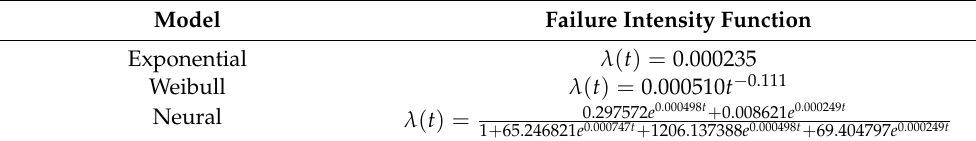
Table 7. Failure intensity functions.